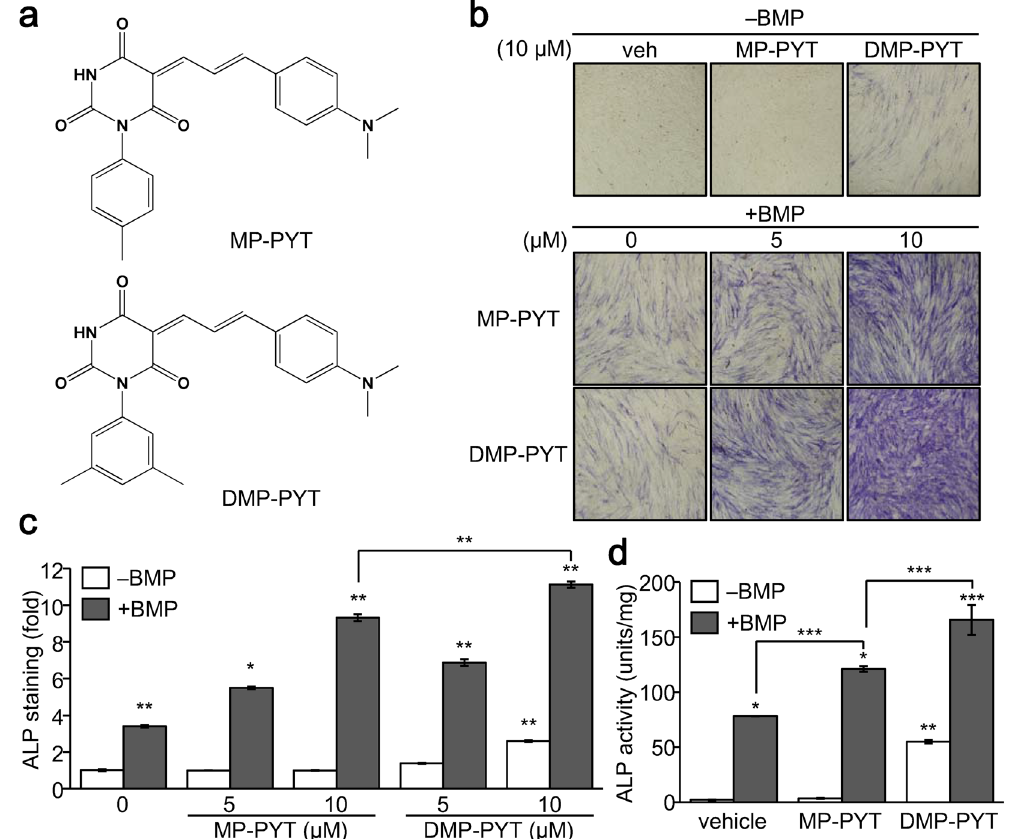
Figure 2. Isolation of novel osteogenic compounds. ( a ) Structure of MP-PYT and DMP-PYT. ( b–d ) C2C12 cells were induced to differentiate into osteoblast in the presence of BMP2 (25 ng/ml) and treated with MP- PYT (5 and 10 µ M) and DMP-PYT (5 and 10 µ M) for 6 days. Cells were fixed and incubated with ALP staining solution for 30 min. Cell images were then captured at 10x magnification using a microscope (Olympus IX51) ( b ). Ten microscopic cell images were acquired and processed with the Image J Cell counter analysis tool. ALP staining intensity is expressed as a fold change relative to the control ( − BMP) ( c ). Cell extracts were harvested and used for ALP activity assay ( d ). At least three independent experiments were performed. * P < 0.05, ** P < 0.005, and *** P <